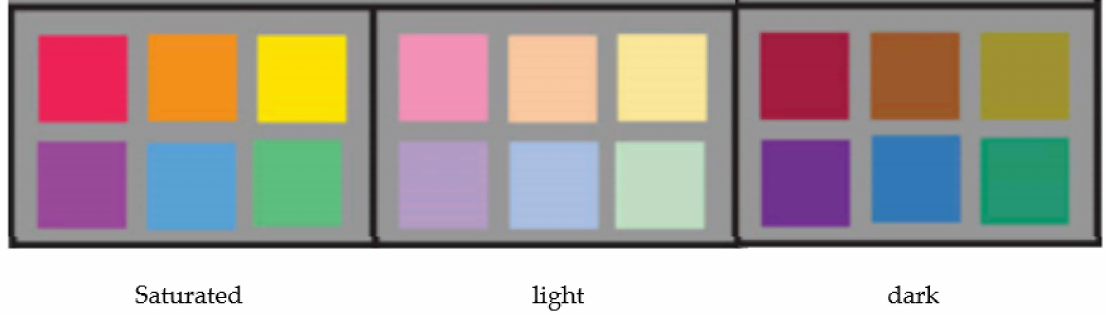
Figure 1. Red (R), orange (O), yellow (Y), green (G), blue (B), and purple (P) using three color dimensions—saturated (S), light (L), and dark